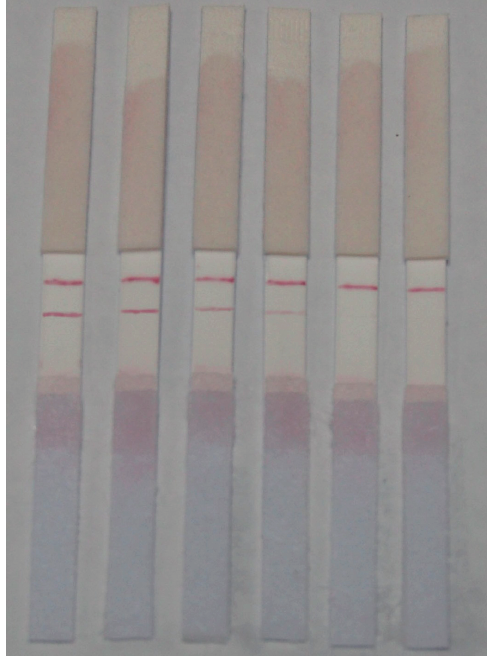
Figure 7. Results on the sensitivity of strips (the concentrations of CAP in the solutions is 0, 0.2, 0.5, 1 and 2 ng/mL respectively, from left to